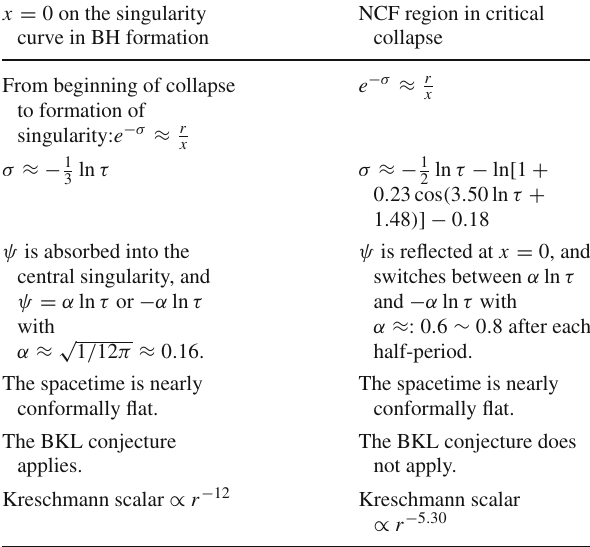
Fig. 8 ln K vs. ln r , where K is the Kreschmann scalar. The relation of ln K vs. ln r is fit according to f ( x ) = ax + b with a = − 5 . 30 ± 0 . 04 and b = − 27 . 16 ± 0 . 38. Slice: x = 4 . 75 × 10 − 4 Table 1 BH formation vs. critical